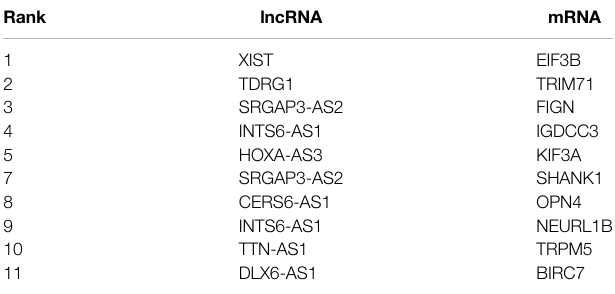
TABLE 4 | Targeted messenger RNAs (mRNAs) predicted by differentially expressed long non-coding RNAs (lncRNAs) using the integrated data.